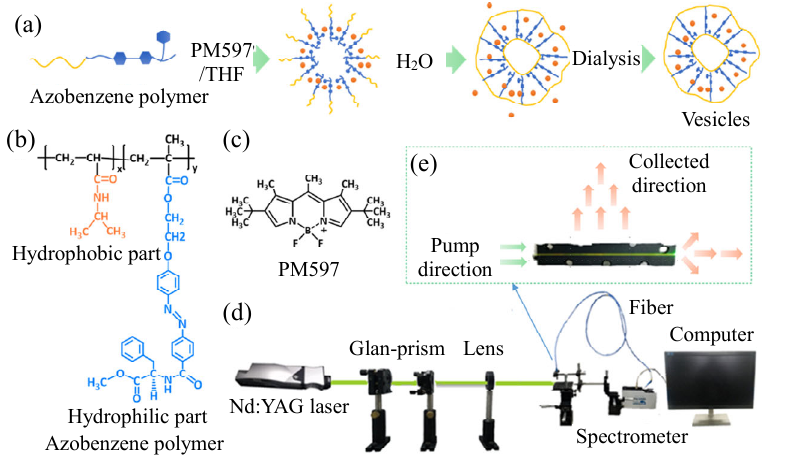
Fig. 1 Vesicles material structure and random lasing experimental setup: (a) self-assembly process of dye doped vesicles, (b) molecular structures of the azobenzene polymer, (c) molecular structures of PM597, (d) setup of the random lasing measurement, and (e) pump direction and the collected